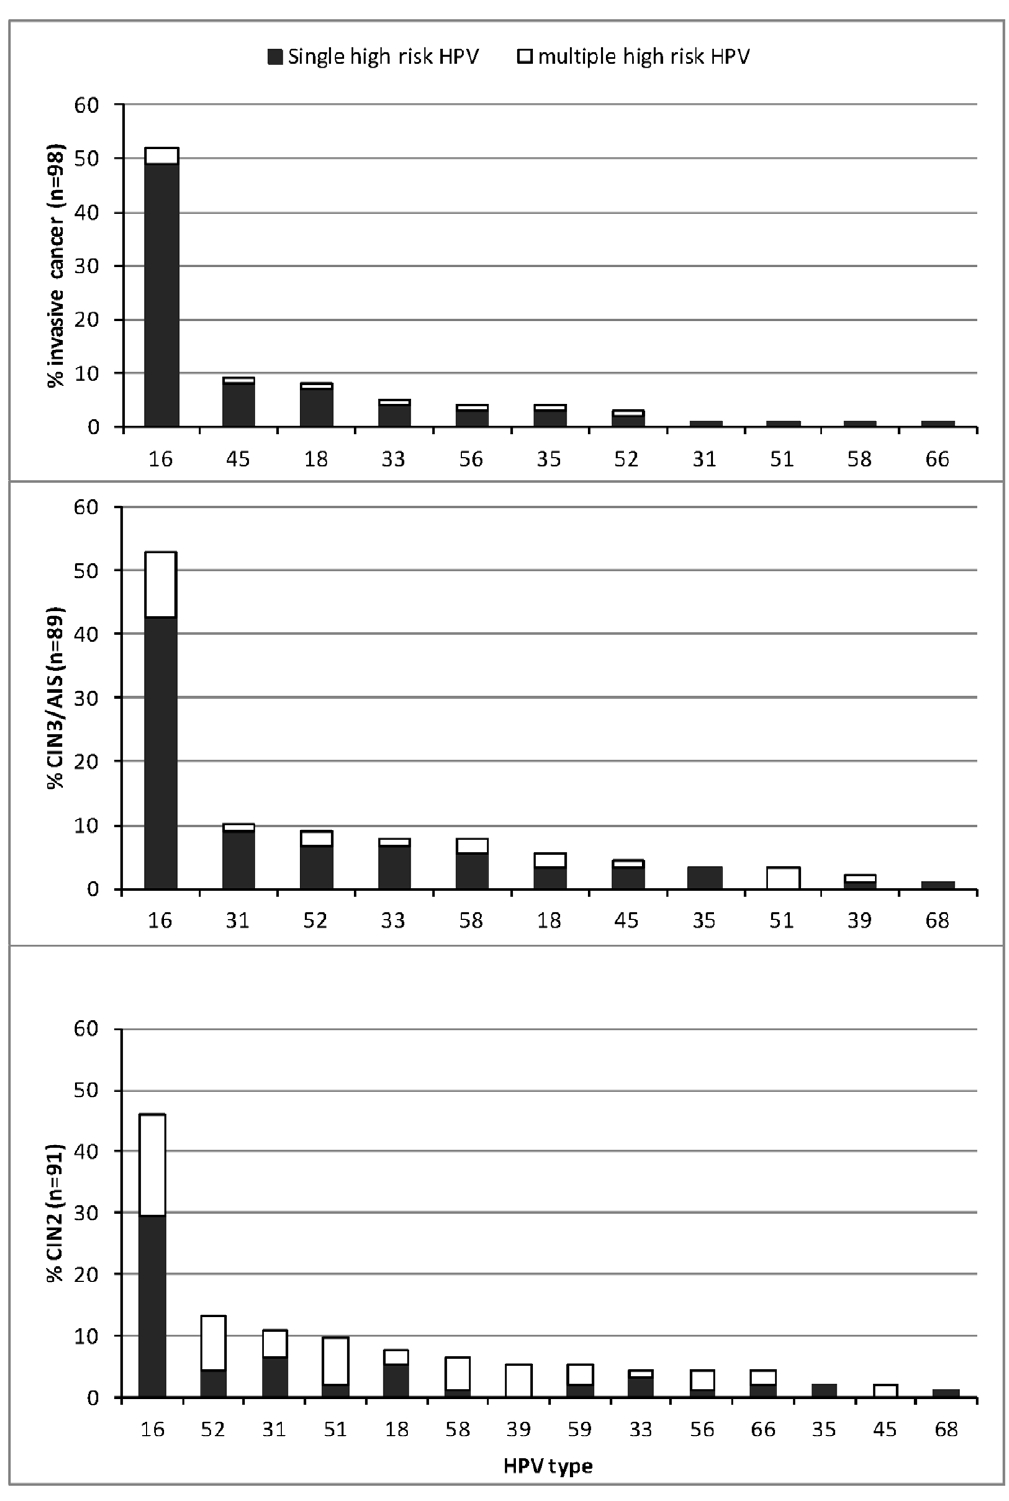
Figure 1. Distribution of single and multiple high risk (HR) HPV types by diagnosis grade.